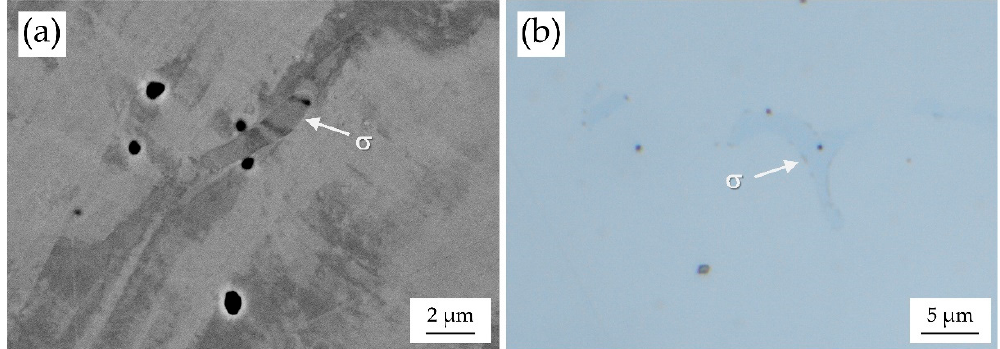
Figure 9. Identification of intermetallic σ phase. ( a ) CBS–SEM image from sample air-1.2; and ( b ) OM image from sample argon-1.2.